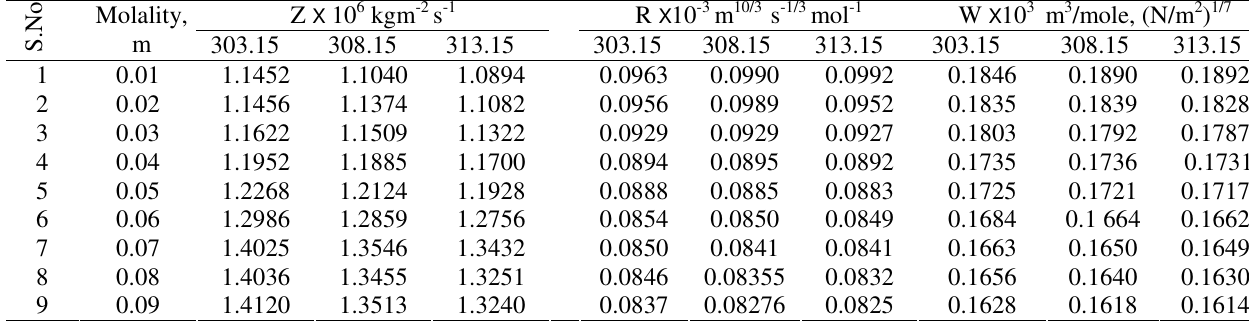
Table 3. Calculated values acoustical impedance (Z), molar sound velocity (R) and molar sound compressibility (W) of 1,4-dioxane + chloroform + cyclo hexane at 303.15, 308.15 and 313.15